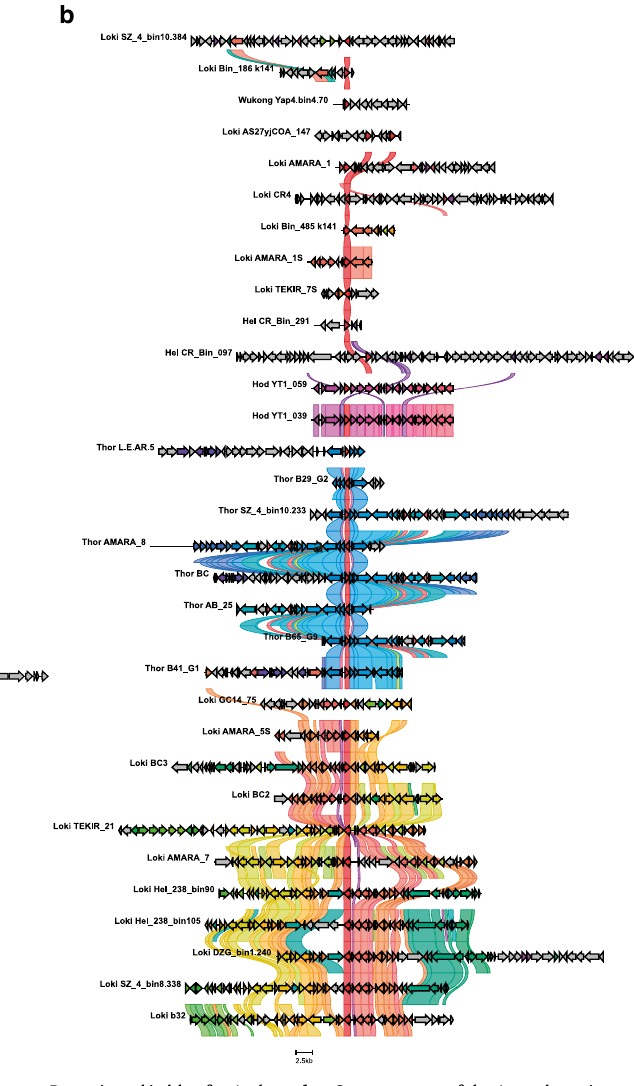
BacteriaandinblueforArchaea. b,c SyntenymapsoftheAsgardcontigsencoding thyA and thyX . The colored tapes indicated homologous genes between the dif- ferent contigs. Contigs have been sorted by their level of shared gene synteny and centered on the thyx and thyA genes (indicated in